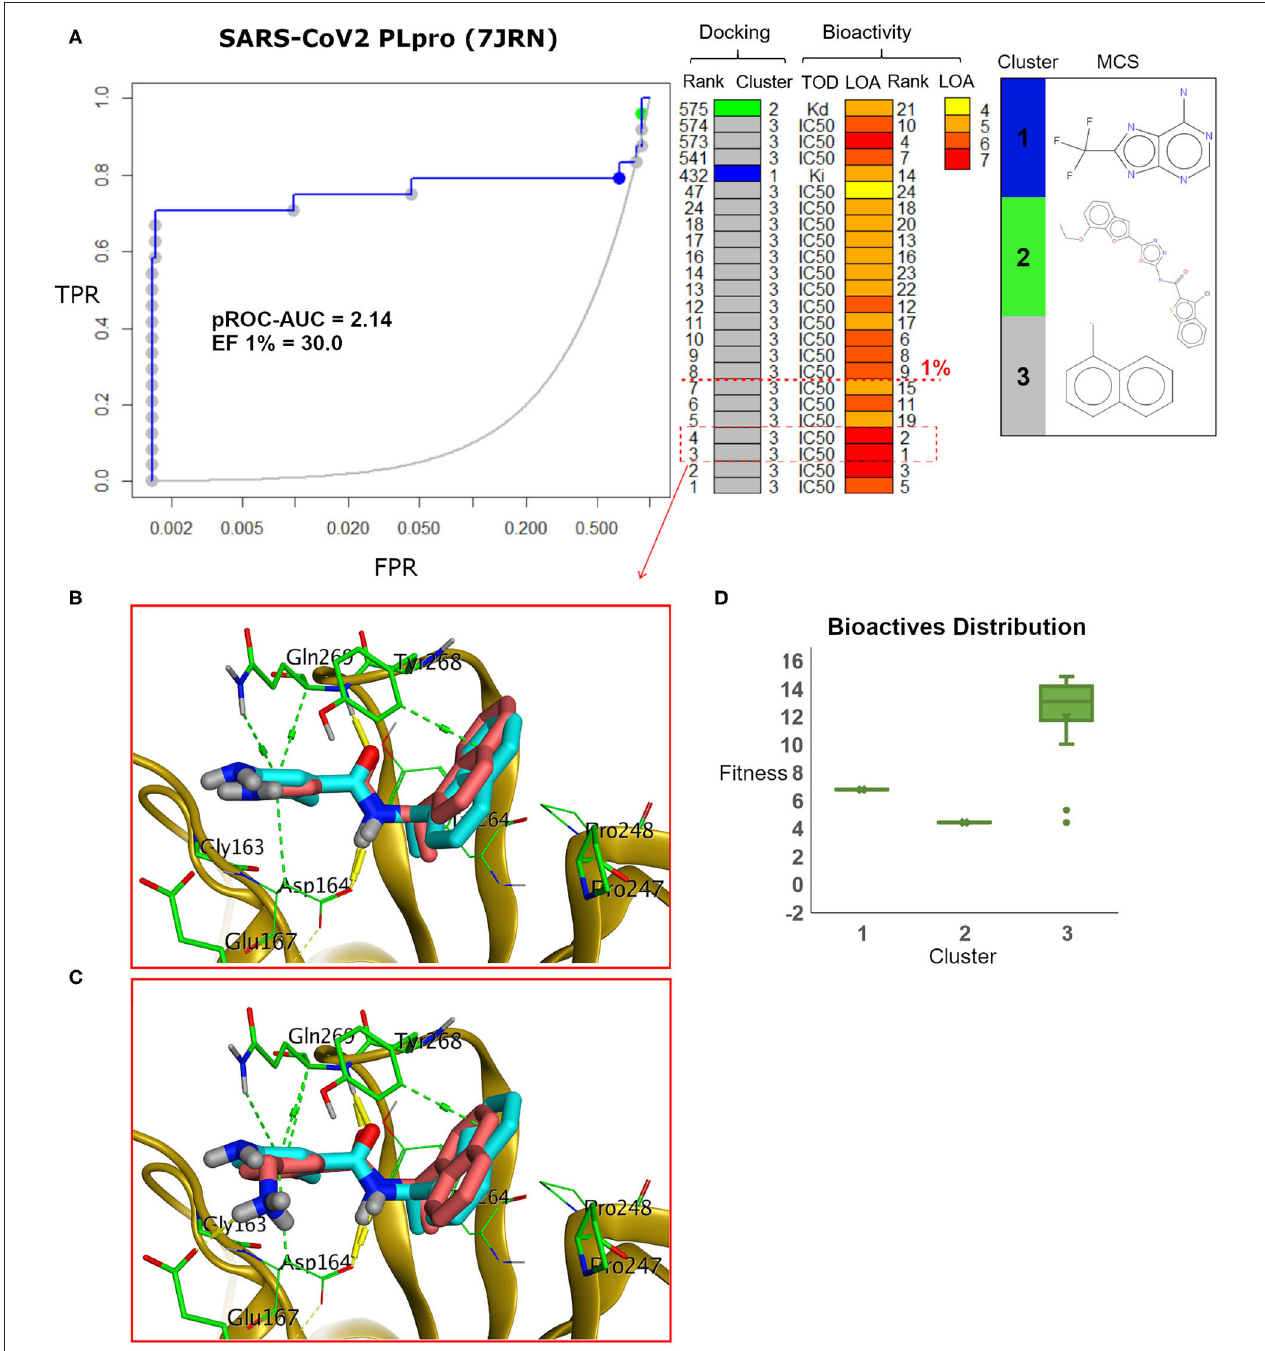
FIGURE 9 | (A) pROC-Chemotype plot of the recently introduced SARS-CoV-2 PLpro (PDB ID: 7JRN) using the FRED docking tool. The docking information is matched with the chemotype represented by the cluster number and the bioactivity information. (B,C) The docking poses of the two best bioactive molecules (i.e., bioactivity rank 1 and 2) overlaid on the co-crystal ligand as salmon and cyan sticks, respectively. (D) Box plot of the fitness vs. chemotype clusters illustrating the bioactive molecule distribution.